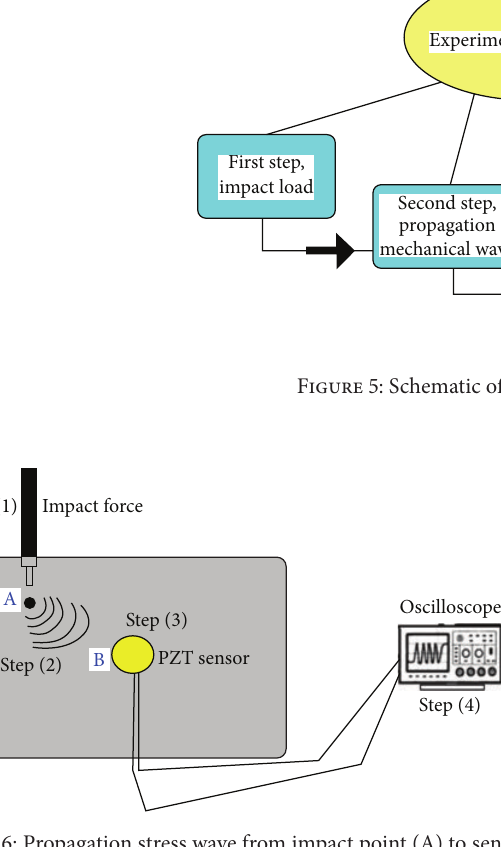
Figure 6: Propagation stress wave from impact point (A) to sensor (B).